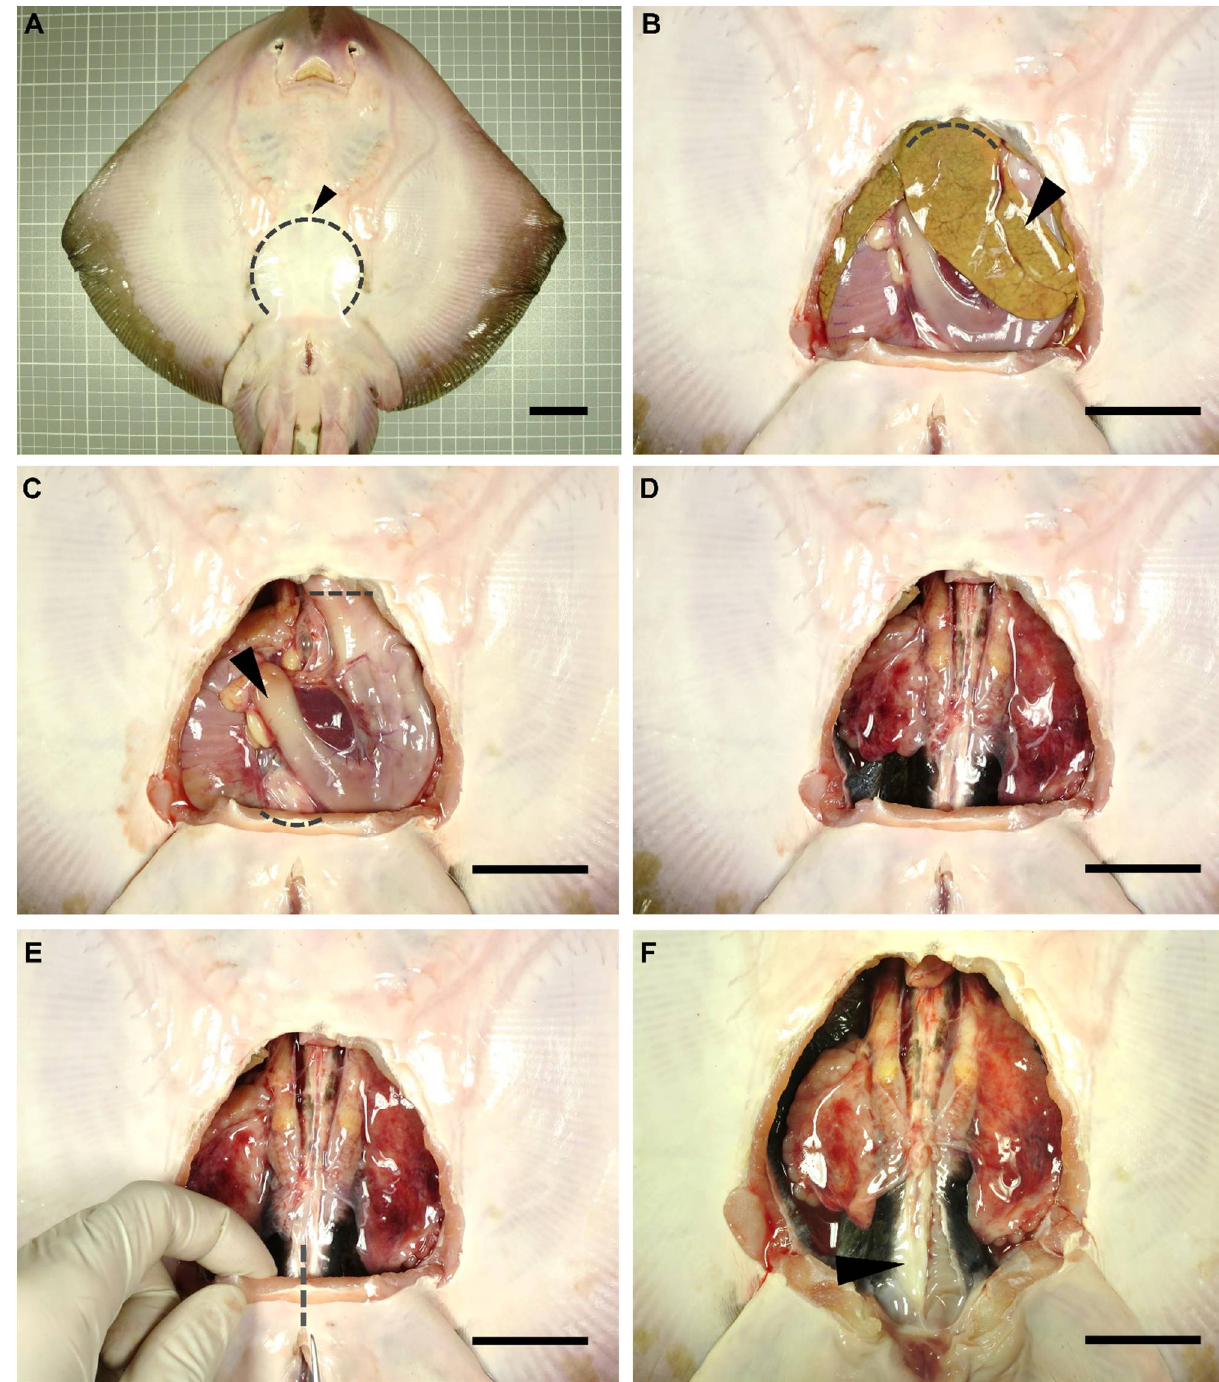
Figure 1. Dissection procedure. Relevant steps in the dissection procedure of a rough skate ( Raja radula ) male to reach the reproductive system ( A ). Removal of the abdominal wall (skin, muscle, parietal peritoneum) to gain access to the pleuroperitoneal cavity ( B ). Extraction of the liver ( C ) and digestive system ( D ). Incision of the puboischiadic bar ( E ) to fully expose the cloaca and the reproductive system ( F ). Arrowhead ( A ): coracoid bar; ( B ): liver; ( C ): digestive system; ( F ): parietal peritoneum. Dotted lines mark incision areas. Dotted line ( A ): abdominal wall; ( B ): cranial liver attachments; ( C ): oesophagus and rectum; ( E ): puboischiadic bar. Scale bar indicates 4 cm.